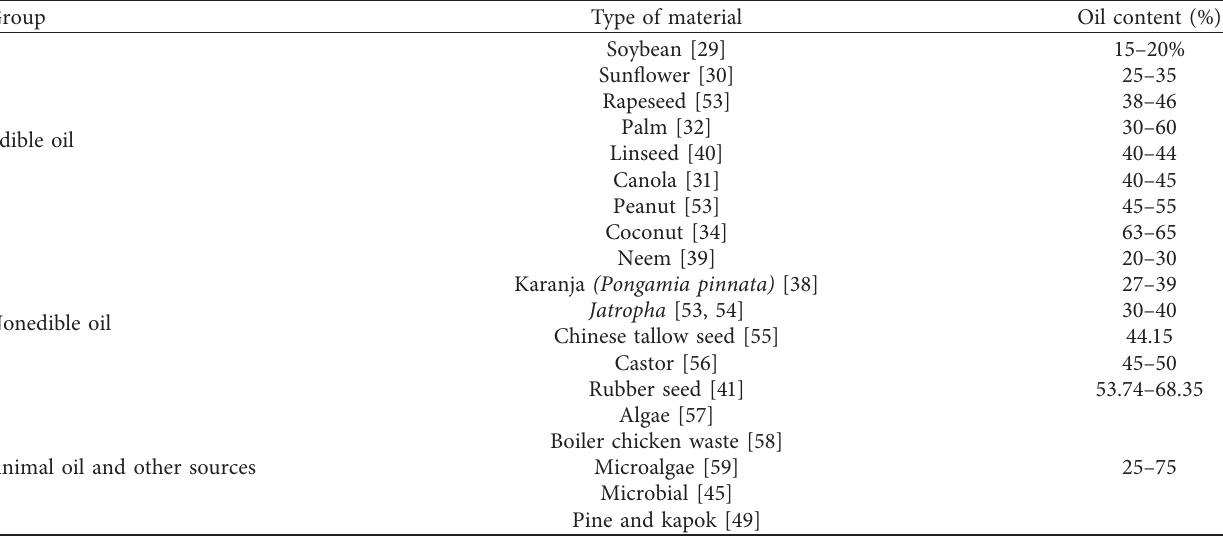
Figure 1: Biodiesel production process of various generations Table 1: Percentage of oil content in various types of biodiesel feedstock.